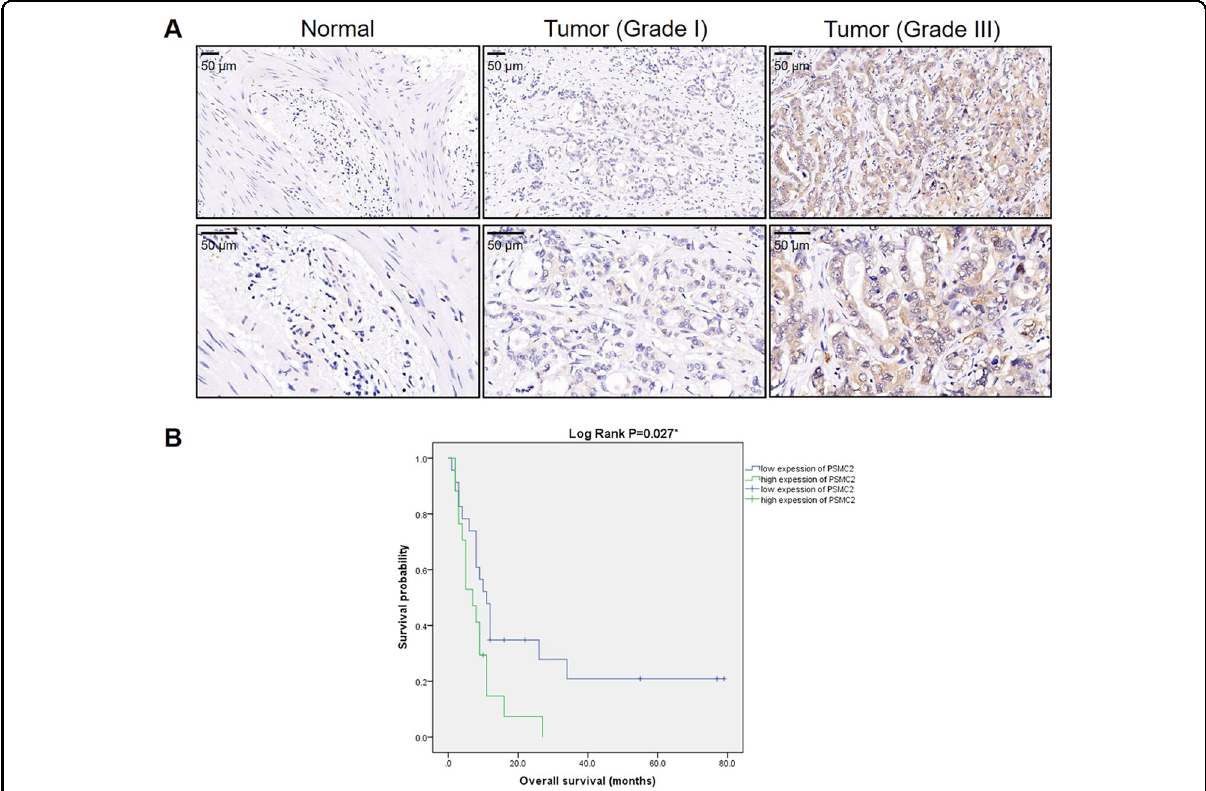
Fig. 1 PSMC2 was upregulated in GBC tissues and predicted poor prognosis. A The expression level of PSMC2 was detected by IHC analysis in GBC tissues and normal tissues. B The relationship between PSMC2 expression and prognosis of GBC patients was statistically analyzed by Kaplan – Meier survival